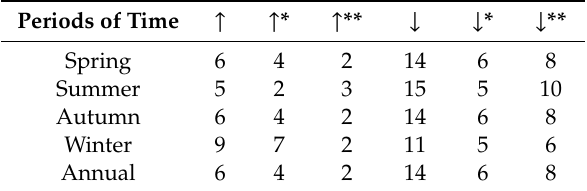
Table 1. Variation trends of the C-factor value of weather stations.